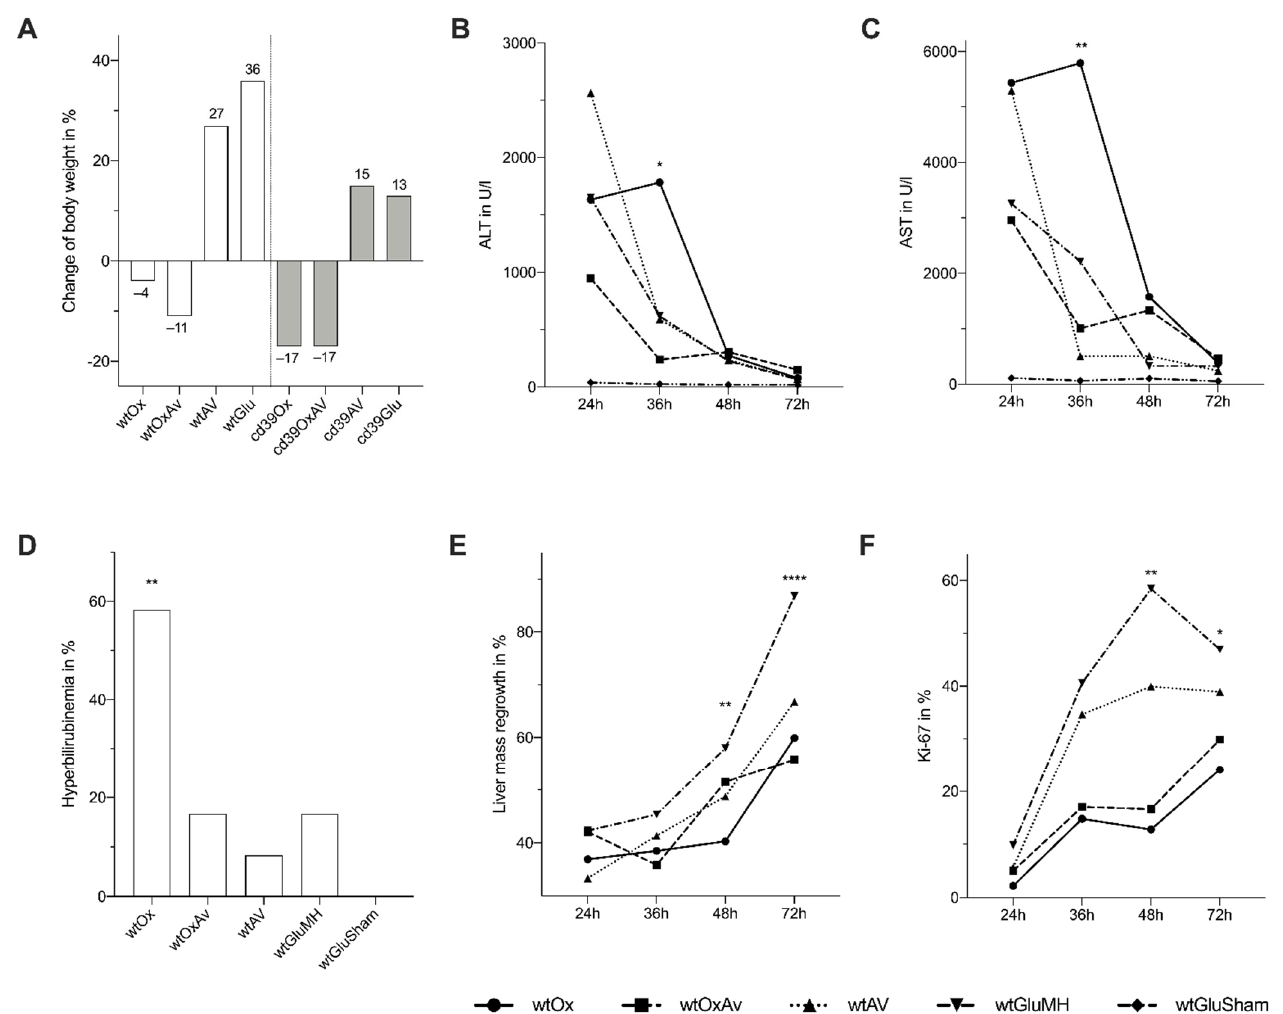
Figure 5. Course of treatment and results after major partial hepatectomy. (* p ≤ 0.05, ** p ≤ 0.01, **** p ≤ 0.0001) ( A ) Relative change of body weight of animals during the course of treatment (day of first treatment until MH or sacrifice) was − 4%, − 11%, +27%, and +36% in wtOx, wtOxAV, wtAV, and wtGlu, respectively ( p < 0.0001), and − 17%, − 17%, +15%, and +13% in cd39Ox, cd39OxAV, cd39AV, and cd39Glu, respectively ( p < 0.0001). Hence, loss of body weight was observed in all animals receiving systemic chemotherapy. ( B , C ) Plasma was obtained to compare liver parameters. Statisti- 0.003; B ) and AST ( p = 0.002; C ). Highest values for ALT and AST at 36 h after MH were found for wtOx (ALT: p = 0.035, AST: p = 0.004). ( D ) Hyperbilirubinemia after MH was observed in 58%, 17%,